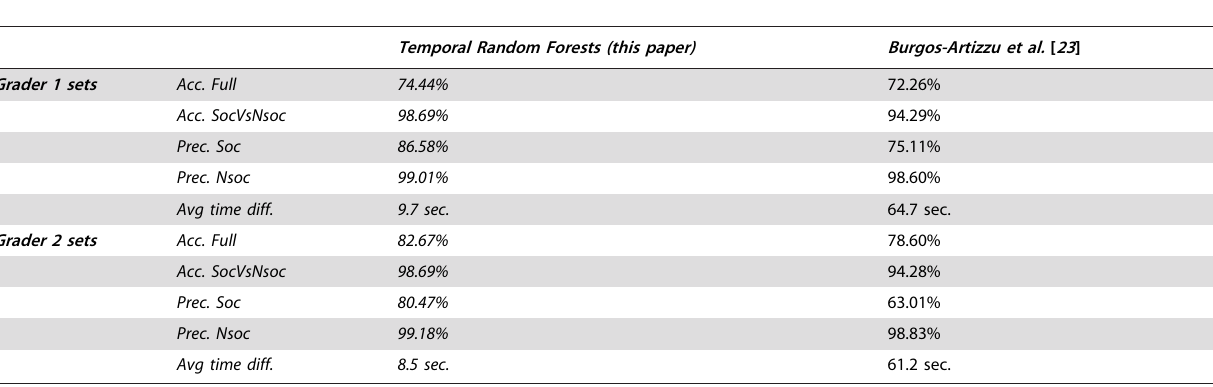
The results are the average across all the mouse pairs of Dataset A, computed employing all the metrics of Table 2 and 3. In all instances our approach outperforms [23]. The full results are available as additional material (Table